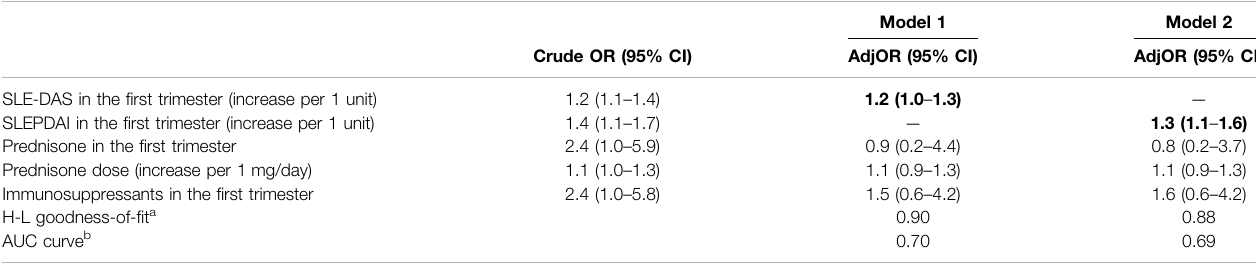
TABLE 4 | Multivariate logistic regression for maternal fl ares. Bold values refer to signi fi cative p values ( p <